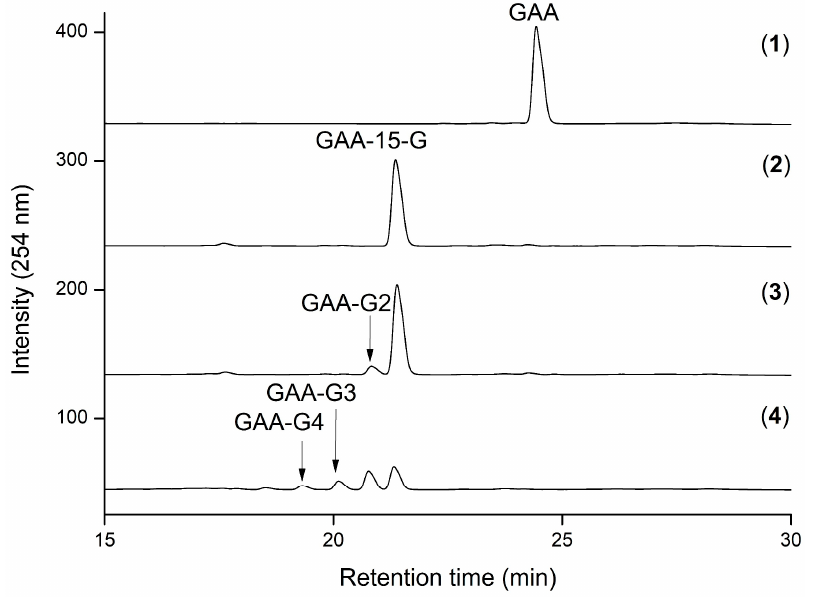
Figure 1. High-performance liquid chromatography (HPLC) analysis of the biotransformation products of ganoderic acid A (GAA) by Bacillus glycosyltransferases (GT), BtGT_16345 and Thermoanaerobacter cyclodextrin glucanotransferase (Toruzyme ® 3.0 L). ( 1 ) GAA only. ( 2 ) Biotransformation product of GAA by BtGT_16345 at 30 ◦ C for 1 h in the presence of 10 mM of phosphate buffer (PB) pH 7.4; 1 mg/mL of GAA; 20 µ g/mL of enzyme; and 10 mM of uridine-diphosphate-glucose (UDP-G). ( 3 ) Biotransformation products of the reaction product in (2) by Toruzyme ® at 60 ◦ C for 4 h in the presence of 50 mM of acetate buffer pH 5.0; 0.3 KNU/mL of enzyme and 2% maltose. ( 4 ) The same condition as that of (3) but with 20% maltose.